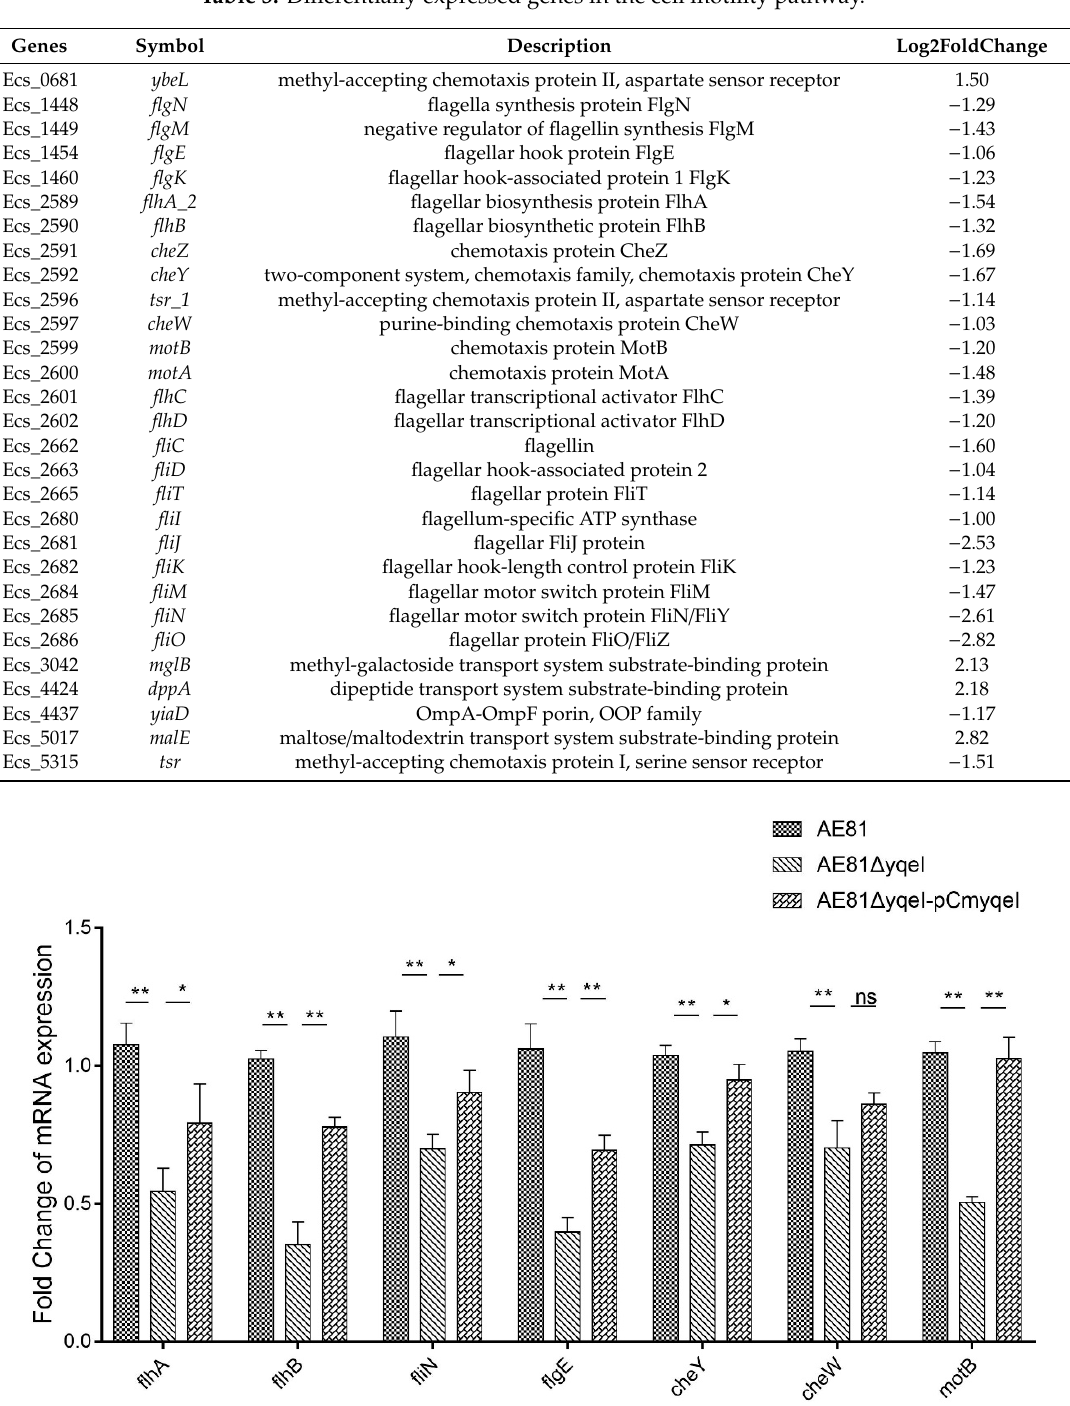
Table 3. Di ff erentially expressed genes in the cell motility pathway.